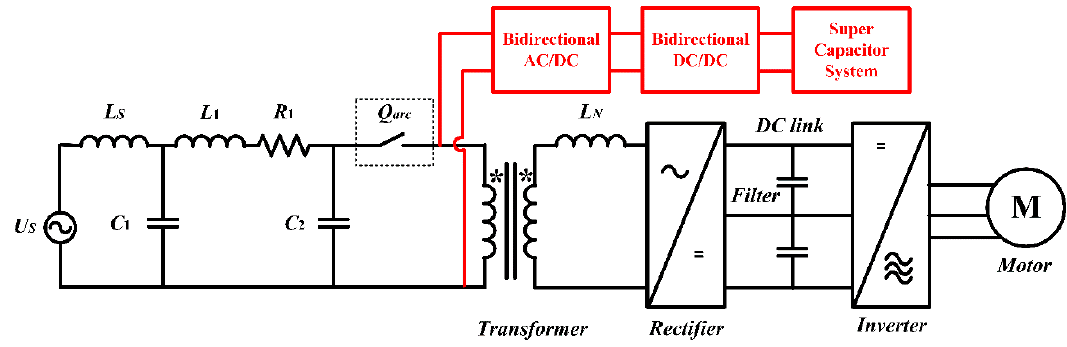
Figure 5. The proposed circuit configuration with bidirectional converters connected with the super capacitor-based energy storage system.